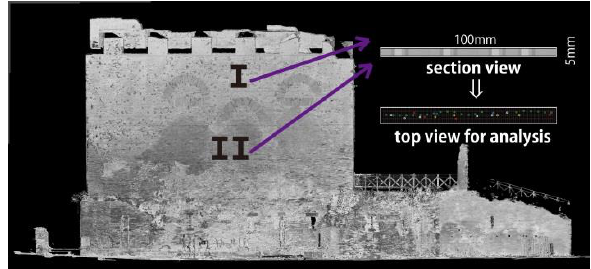
Figure 3: The Sample Objects Picked up for the Demonstration Uneven surfaces of the west-side wall of the temple were cut out as two squares (squares I and II in figure 3) almost randomly. Those squares were so small (100mm wide and 5mm height) that we can ignore shapes more than a few centimetres.